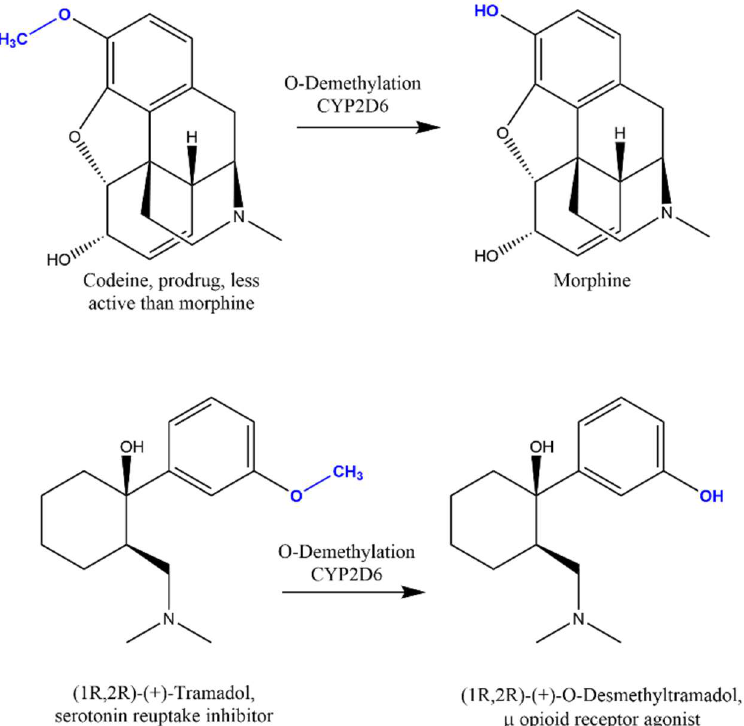
Figure 5. Examples of metabolic pathways for which CYP2D6 polymorphism is important.